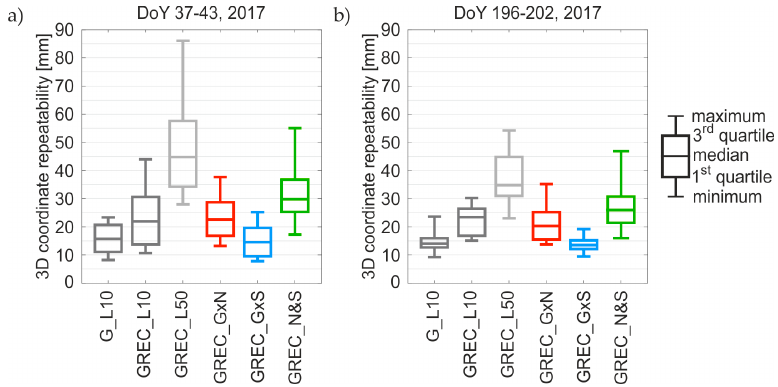
Figure 7. Three-dimensional (3D) coordinate repeatability obtained in static PPP using different weighting schemes. Table 6. Mean coordinate repeatability for all stations during both test